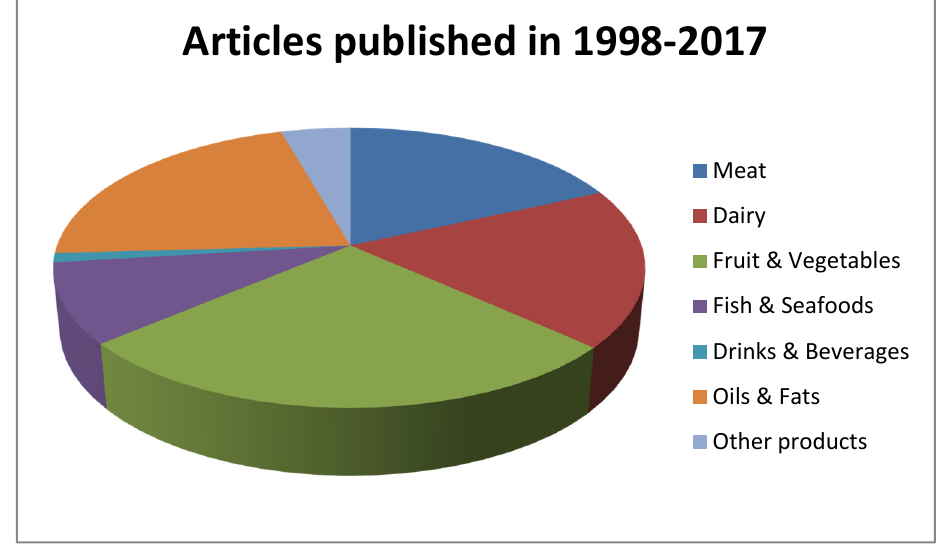
Figure 1. Food processed by High Hydrostatic Pressure Processing (HPP) technologies (period 1998–2016) divided by sectors.